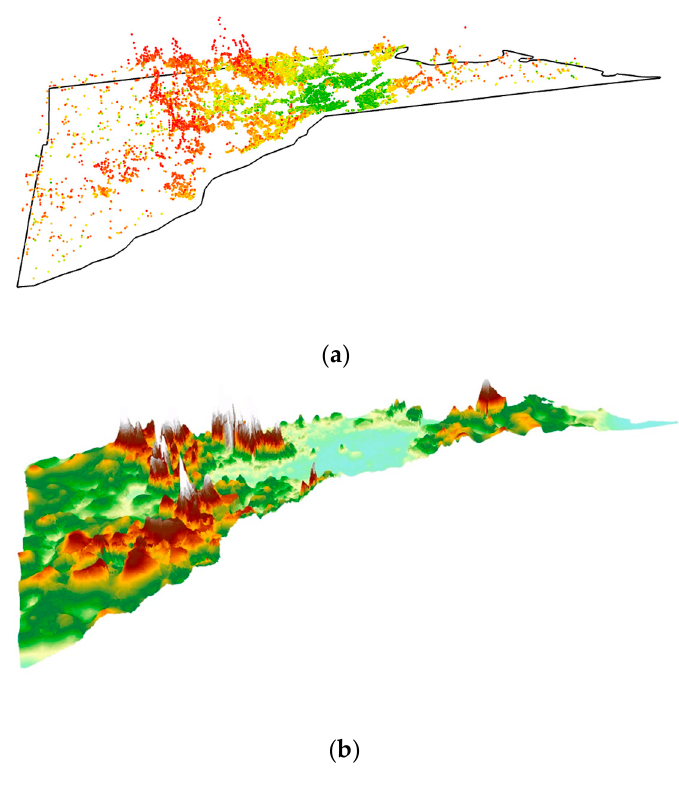
Figure 2. Spatial distributions of house prices from 2012–2016. ( a ) discrete point; ( b ) continuous surface